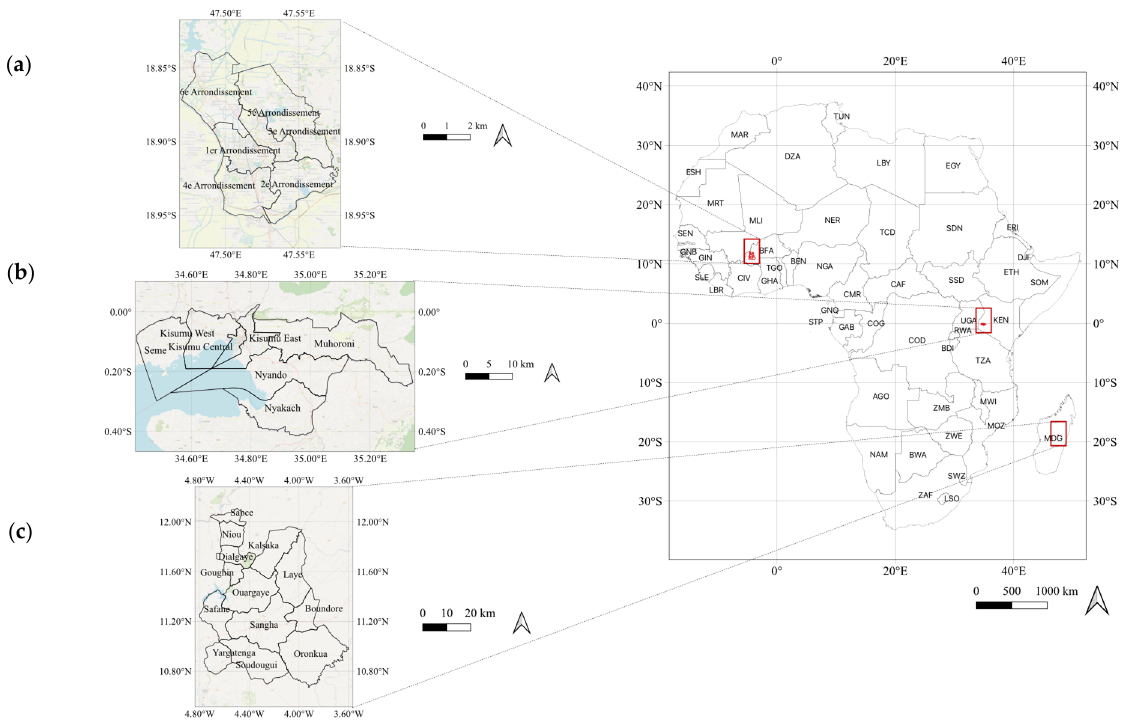
Figure 2. Location map of the study area: ( a ) Houet (Burkina Faso), ( b ) Kisumu (Kenya), ( c ) Anala- manga (Madagascar) in